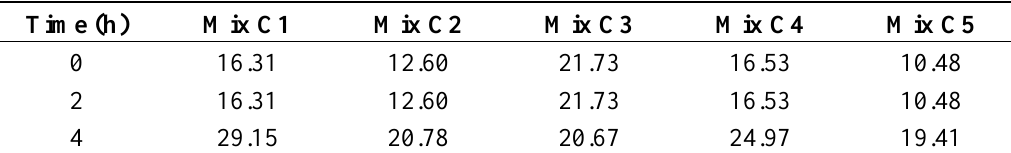
Table 5. Volume fraction of strong flocculation